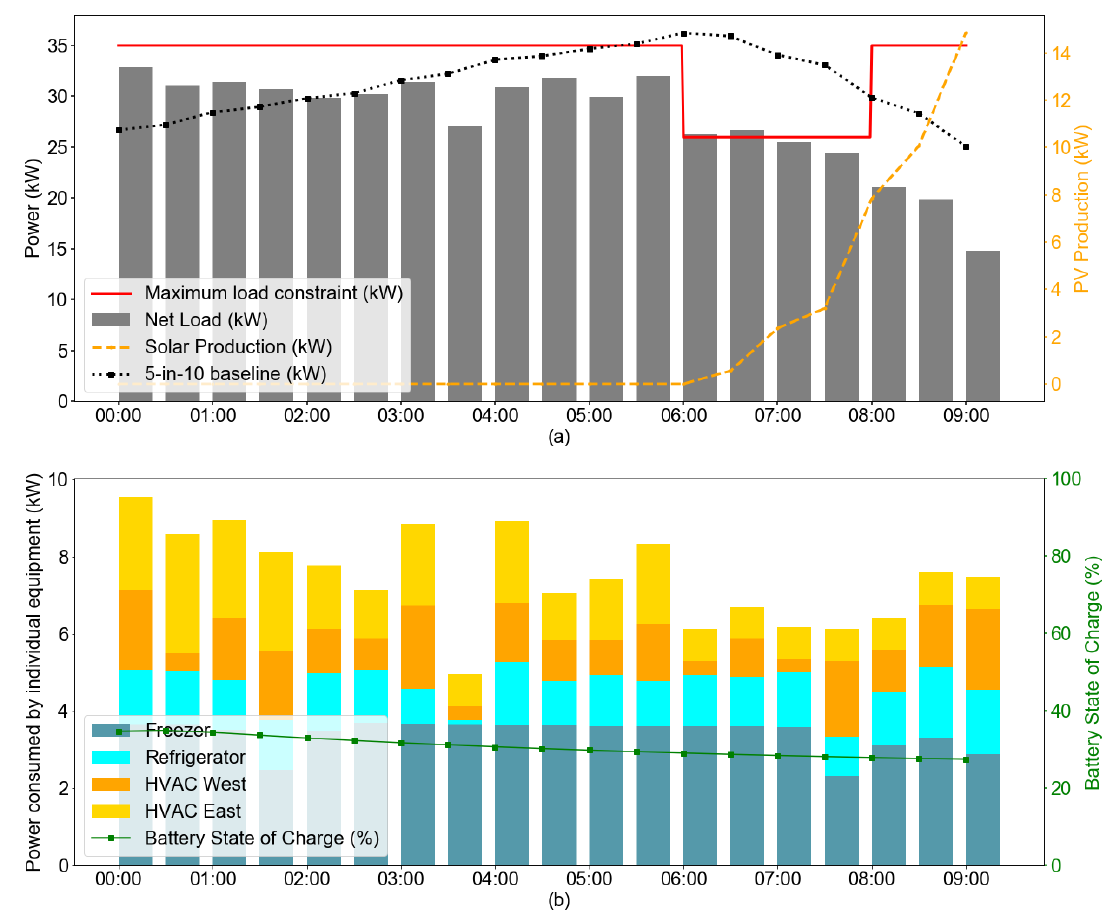
Figure 10. ( a ) Reduction in net load during a 26 kW demand limiting grid signal from 06:00 to 08:00 ( b ) Breakdown of controlled loads; HVAC and freezer loads cause the decrease in net load consumption; the battery was not used during this